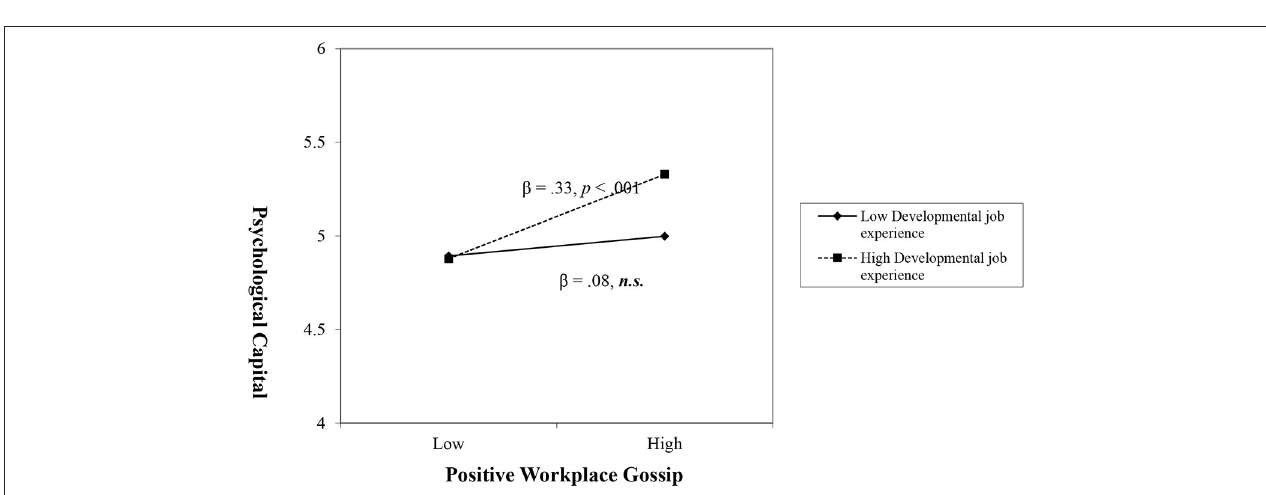
FIGURE 1 | Moderating effect of developmental job experience on the relationship between workplace positive gossip and psychological capital.